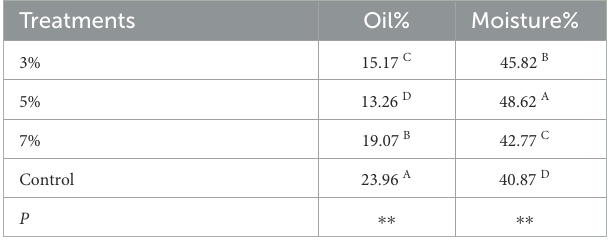
TABLE 2 Oil and moisture contents of different levels of apple peel as coating film for deep-fried falafel balls.